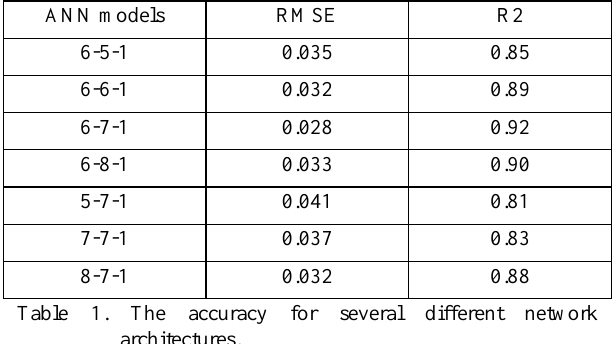
Table 1. The accuracy for several different network architectures.